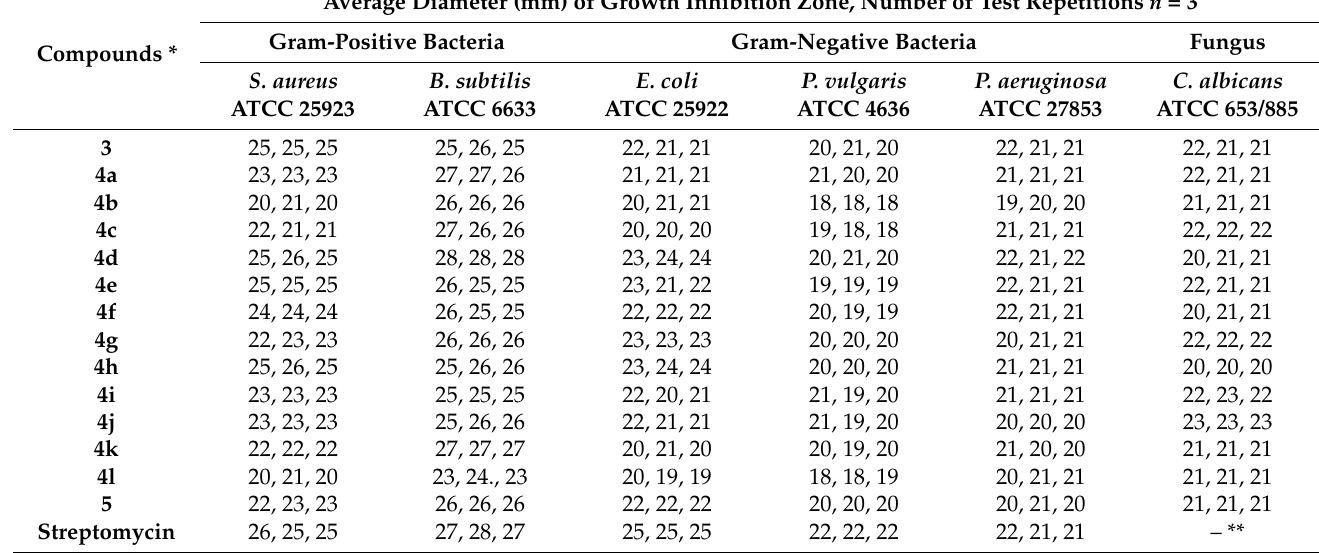
Table 2. Screening data for antimicrobial activity of thieno[2,3- d ]pyrimidine derivatives 3, 4a-l, 5 .